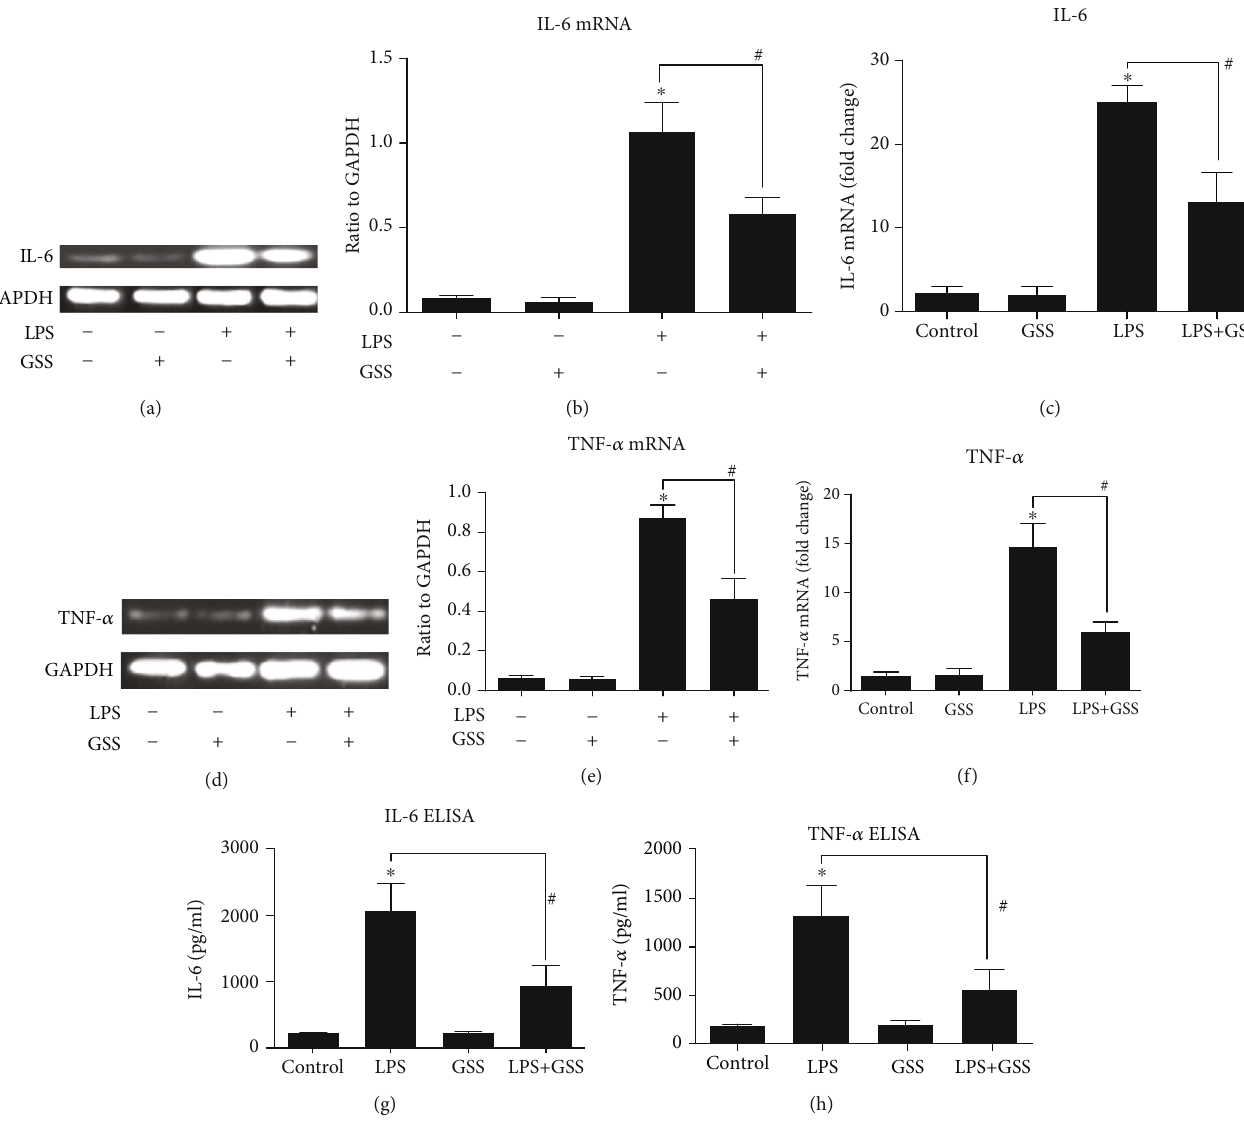
Figure 4: GSS inhibits LPS-induced TNF- α and IL-6 expression in ECs. After stimulation of LPS for 8h, the endothelial cells were collected, and the mRNA and protein expressions of IL-6 and TNF- α were detected by RT-PCR and ELISA. (a) ECs were pretreated with GSS for 2h and then exposed to LPS, and the expression of IL-6 was detected by RT-PCR. (b) The PCR result was presented as a histogram showing the band intensity values. (c) The RT-qPCR results of IL-6 were presented as a histogram. The relative amount was normalized to the housekeeping gene GAPDH. (d) ECs were pretreated with GSS for 2 h and then exposed to LPS, and the expression of TNF- α was detected by RT-PCR. (e) The PCR result was presented as a histogram showing the band intensity values. (f) The RT-qPCR results of TNF- α were presented as a histogram. The relative amount was normalized to the housekeeping gene GAPDH. (g) ECs were pretreated with GSS for 2 h and then stimulated with LPS; the level of IL-6 in supernatant of ECs was determined by ELISA analysis. (h) ECs were pretreated with GSS for 2 h and then stimulated with LPS; the level of TNF- α in the supernatant of ECs was determined by ELISA analysis. ∗ P < 0 : 05 versus negative control. # P < 0 : 05 versus the corresponding LPS treatment